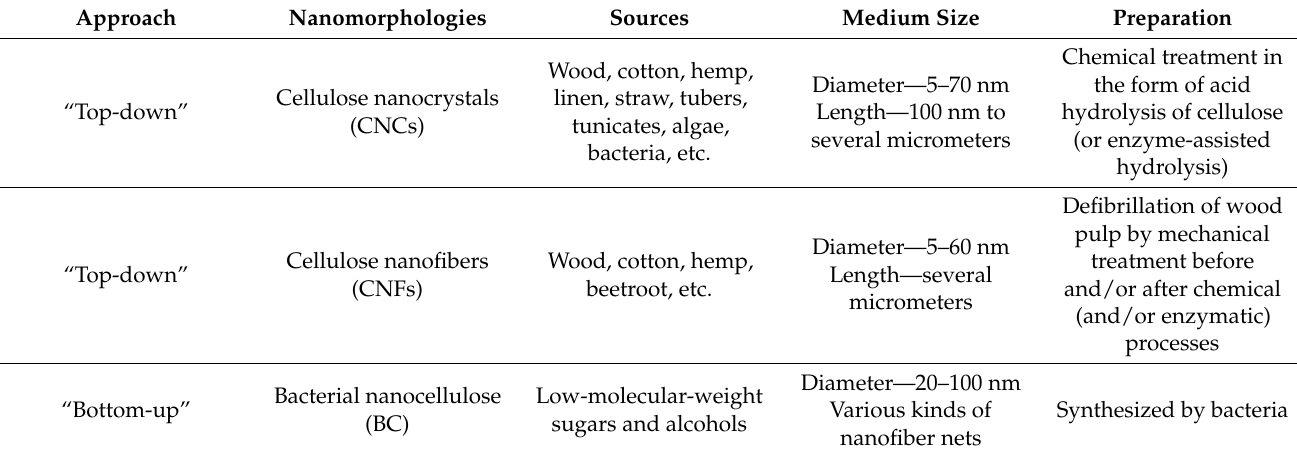
Table 1. Medium size, sources, and preparation of the various cellulose nanomorphologies (adapted from